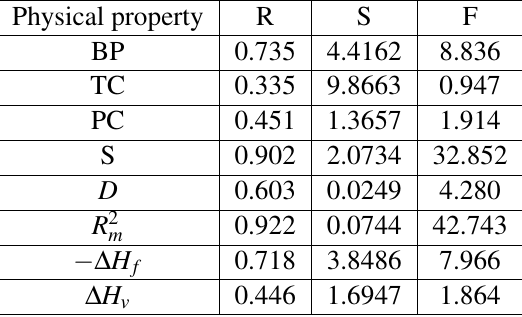
Table 7 Statistical parameters for the QSPR model